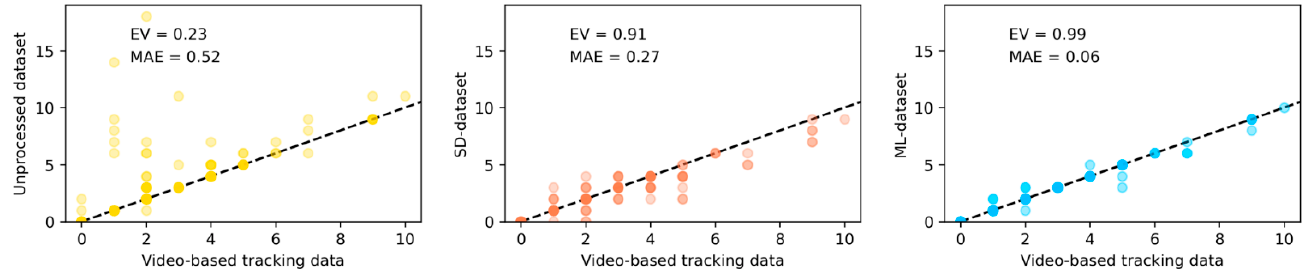
Figure 4. Number of transitions per individual (per batch, per zone) for the unprocessed, SD and ML datasets against video-based tracking data and associated 𝐸𝑉 and 𝑀𝐴𝐸 scores. Overlapping data points are represented by darker shading.